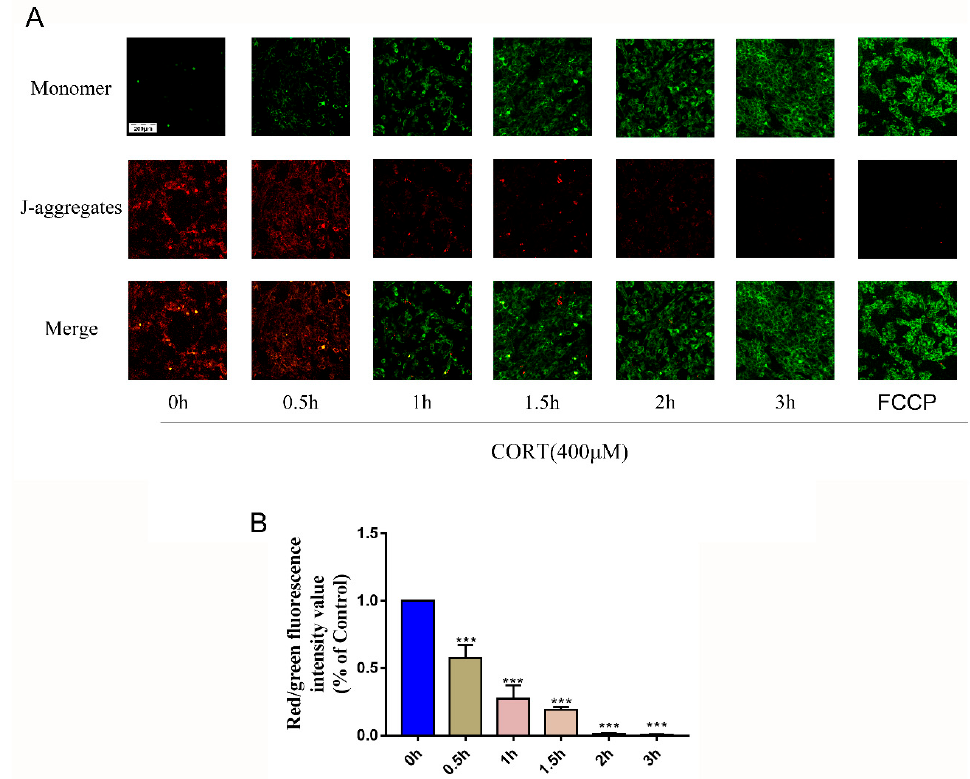
Figure 7. The ∆Ψ m of HT22 cells was measured by JC-1 staining after cortisol (CORT) treatment at different times (0–3 h). Carbonyl cyanide 4-phenylhydrazone (FCCP) was the positive control. FCCP treatment was performed at the end of assay to determine a “zero” ratio, i.e., completely depolarized mitochondria. The red color denotes JC-1 aggregates, the green color denotes monomers, and the ratio of red to green fluorescence denotes changes in the mitochondrial membrane potential ( A ). The bar graph shows the ratio of red to green fluorescence at every time point ( B ). Data were between control (CORT 0 μ M) vs. CORT (400 μ M) at different times, and were analyzed by one-way analysis of variance. The results are expressed as the mean ± SD ( n = 3) in each independent experiment; *** p < 0.001.